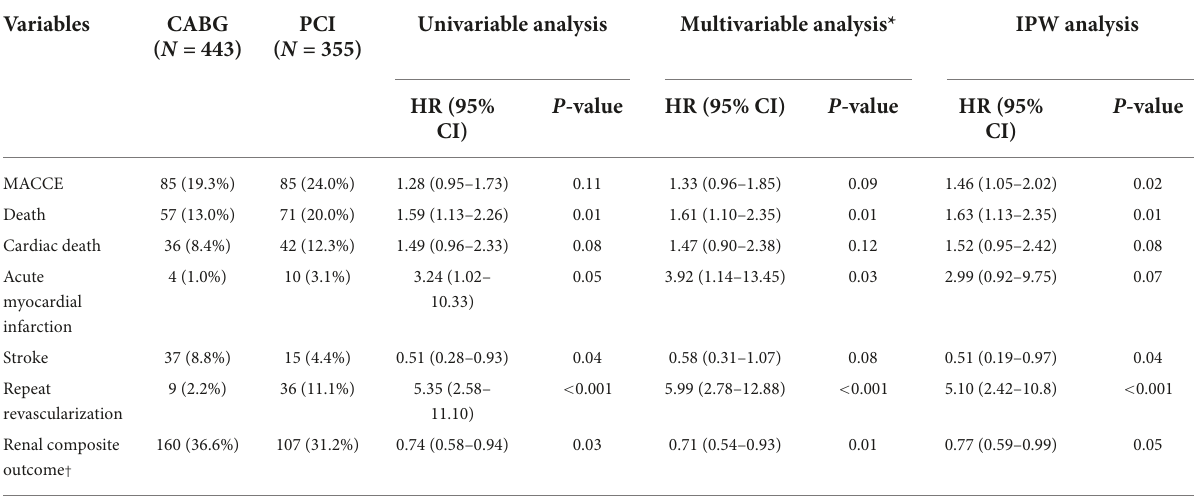
TABLE 2 Comparison of clinical outcomes at 5 years in the CABG and PCI